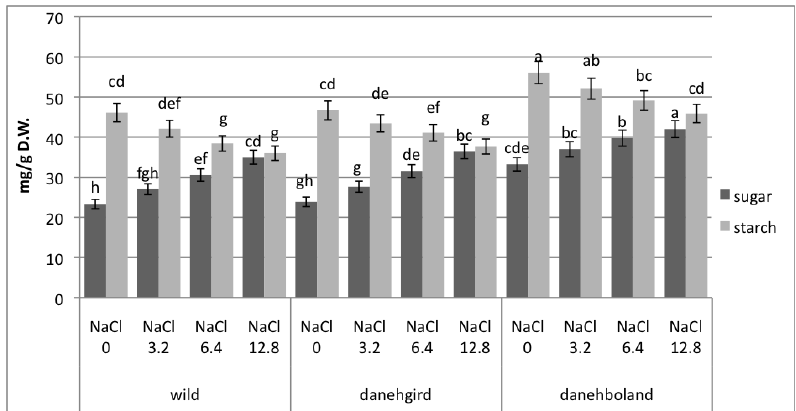
Fig. 1: Sodium chloride effect on leaf sugar, starch content mg g -1 D.W. of non-grafted wild, grafted ‘Danehgird’ and ‘Danehboland’ cultivars of Z. spina- christi . In each measured factor (sugar, starch), columns followed by the same letter are not significantly different at p≤0.05, using Tukey’s test. The data are the means±SE (